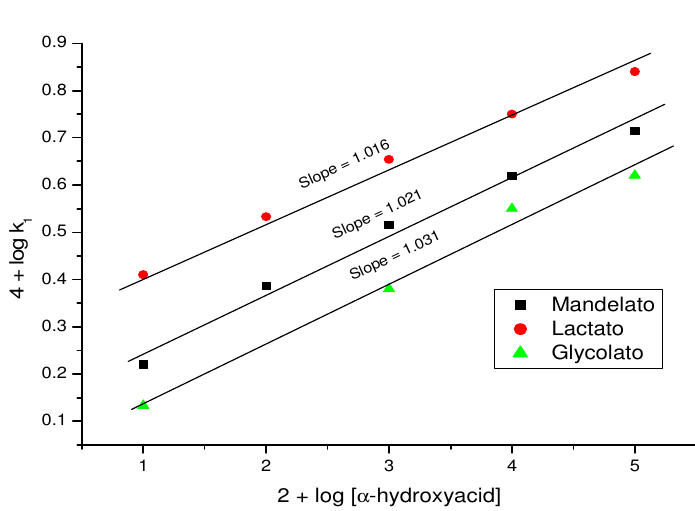
Figure 4. Dependence of rate on [ α -hydroxyacid ] in